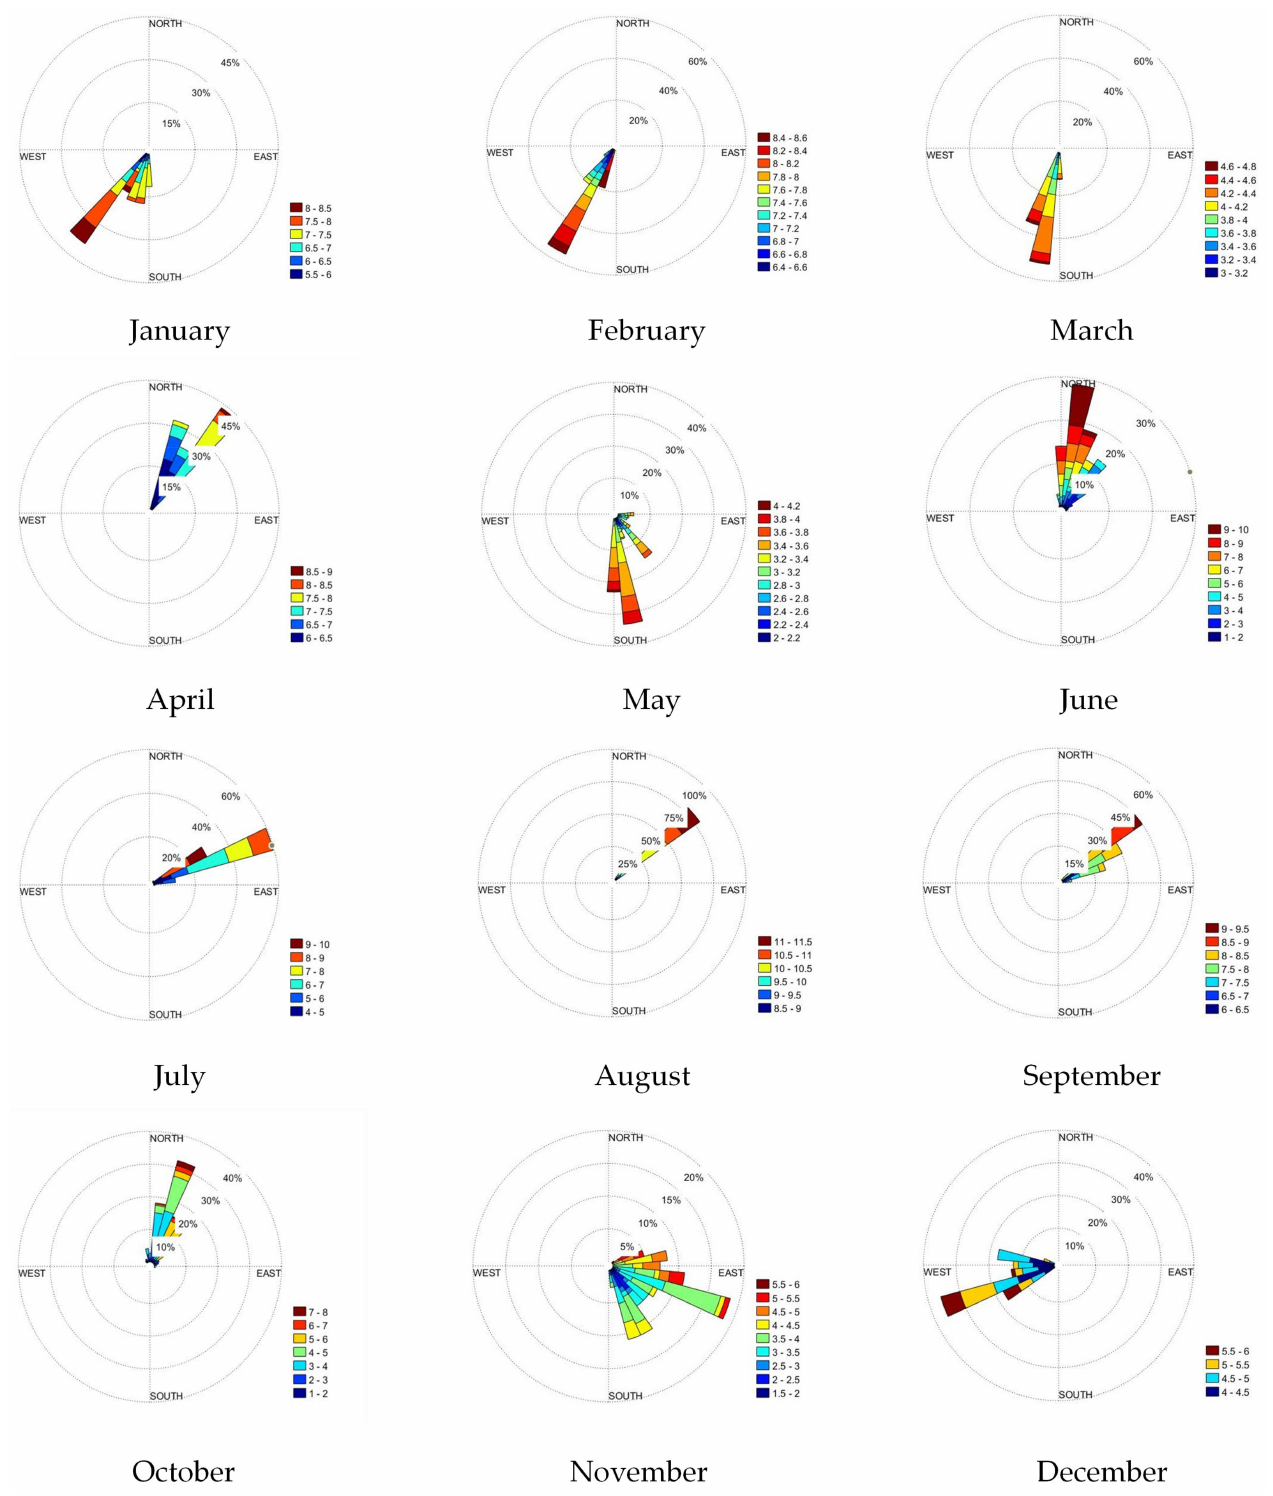
Figure 15. Wind rose in Bay of